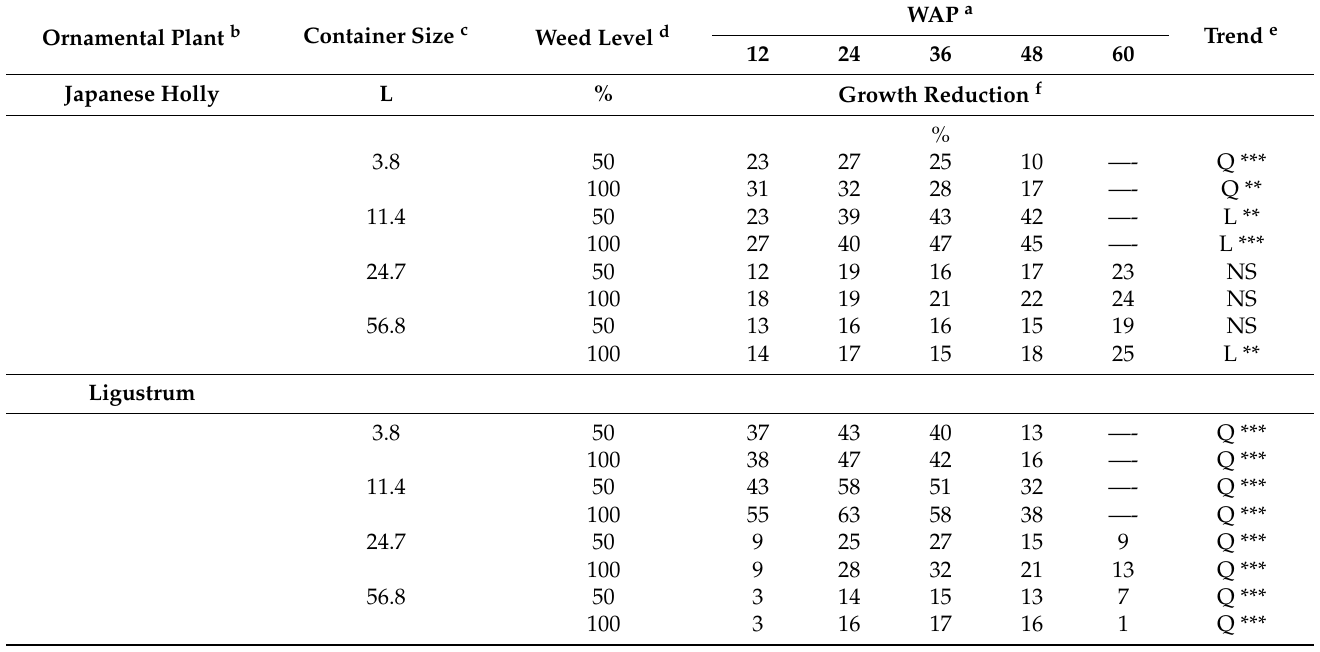
Table 2. Growth reduction from 50% or 100% weed coverage over time in either Japanese holly or ligustrum grown in four different container